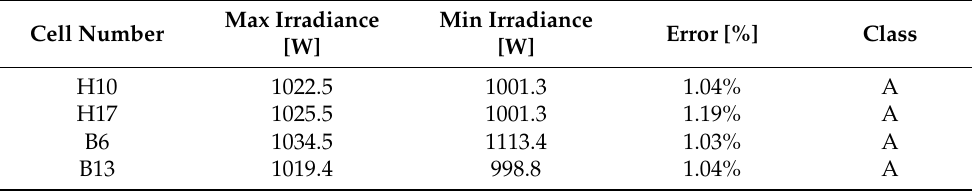
Table 5. Long ‐ term instability values at a specific point. Table 5. Long-term instability values at a specific point.